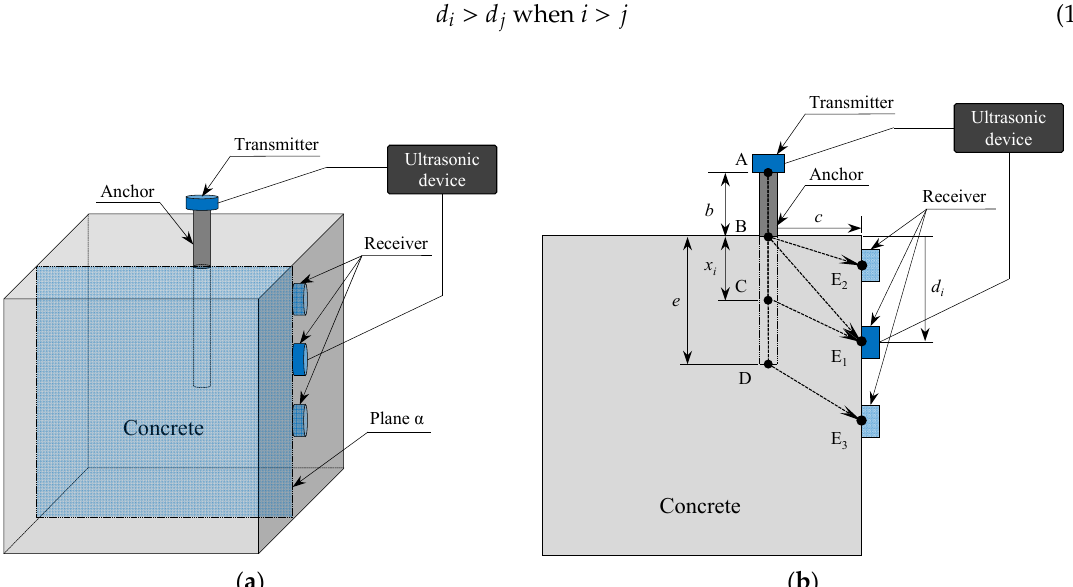
Figure 2. Schematic illustration of the ultrasonic test process conducted to estimate the embedded depth of anchor bolt: ( a ) three-dimensional view of the test specimen and set up; and ( b ) the cross-section of the plane α .